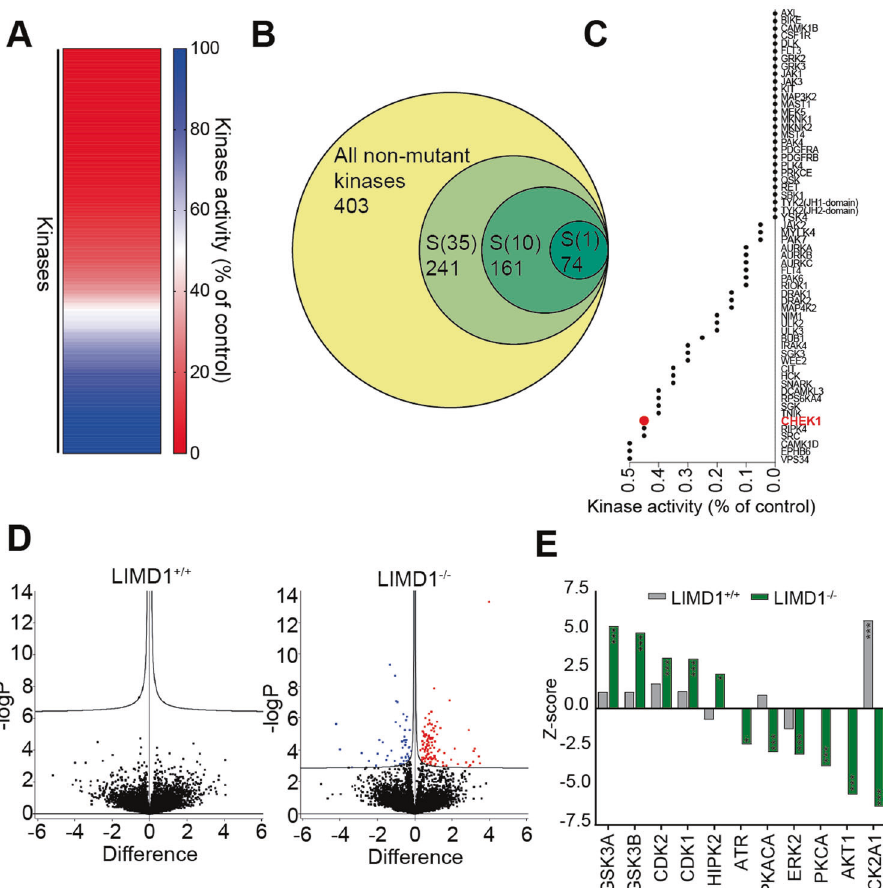
Fig. 3 PF-477736 is a broad-spectrum kinase inhibitor that elicits LIMD1 − / − -speci fi c cellular changes in the phosphoproteome. A Heatmap showing remaining kinase activity of a panel of in vitro kinases upon 3 µM PF4-77736 treatment in DiscoverX KINOMEscan assay. B Venn diagram representing the proportion and number of kinases inhibited to less than 35%, 10% and 1% of control activity. C Waterfall plot of kinases most inhibited by PF-477736 (3 µM) in the in vitro kinase assay. D Volcano plot of phosphosite changes between 1 µM PF- 477736-treated and DMSO control lysates in isogenic HeLa lines. Cells were harvested following 1 h drug treatment. No signi fi cant phosphosite changes were induced by PF-477736 in the LIMD1 + / + cell line, compared with 54 reduced and 119 increased phosphosites in the LIMD1 − / − cell line. Cut-off point for statistically signi fi cant phosphosite is a false discovery rate of >0.05 and S0 of 0.01 ( n = 3). E Kinase substrate enrichment analysis (KSEA) of phosphoproteomics shows kinases signi fi cantly affected by PF-477736 treatment in LIMD1 + / +